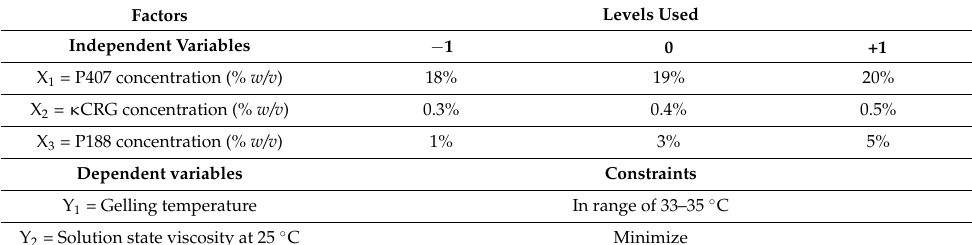
Table 1. Experimental design used in BBD for optimization of NEB-loaded dual-responsive in situ gels. Factors Levels Used Independent